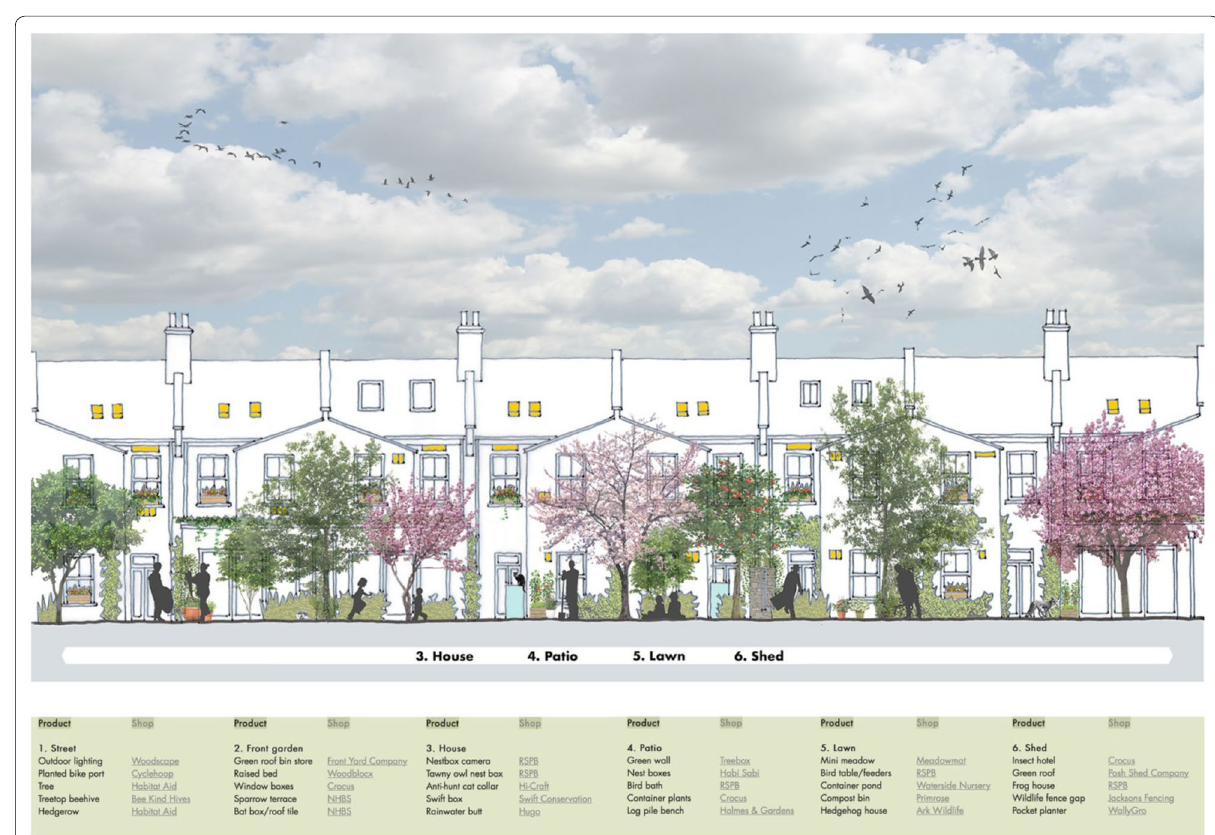
Fig. 4 Back garden elevation showing proposed typical street with adaptations for biodiversity, focusing on products (Siân & Jon Moxon & Viktoria